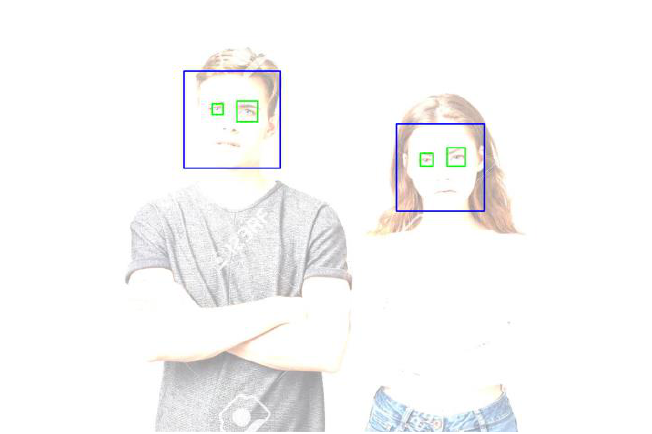
Figure 36. After increasing the brightness of Figure 34.